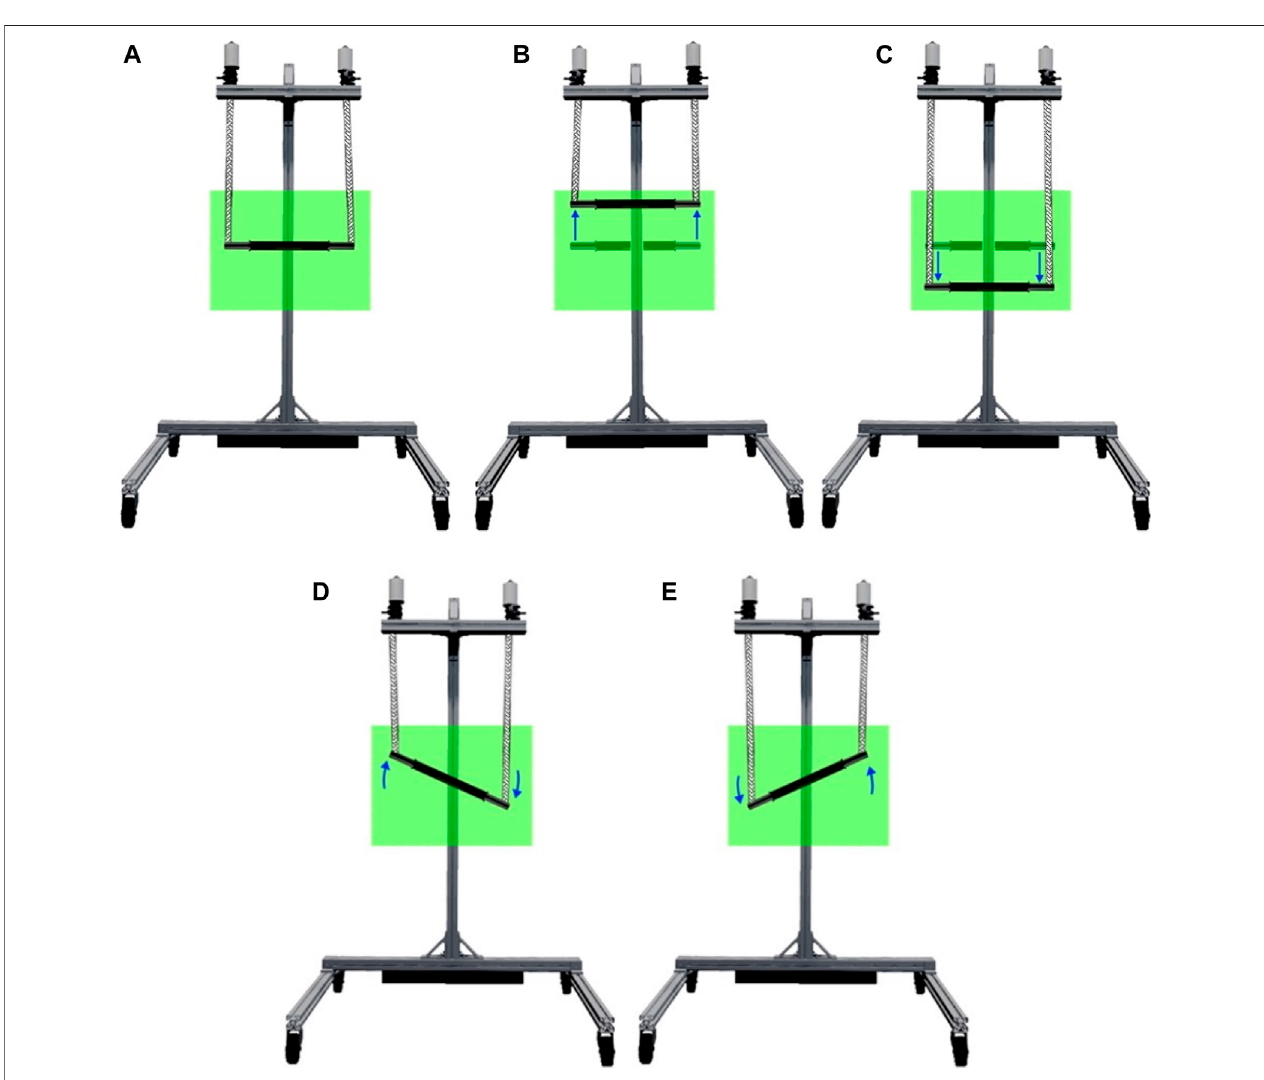
FIGURE4| BimanualrobotDOF, (A) initialposition, (B) upwardmovement, (C) downwardmovement, (D) clockwisemovement, (E) counterclockwisemovement.